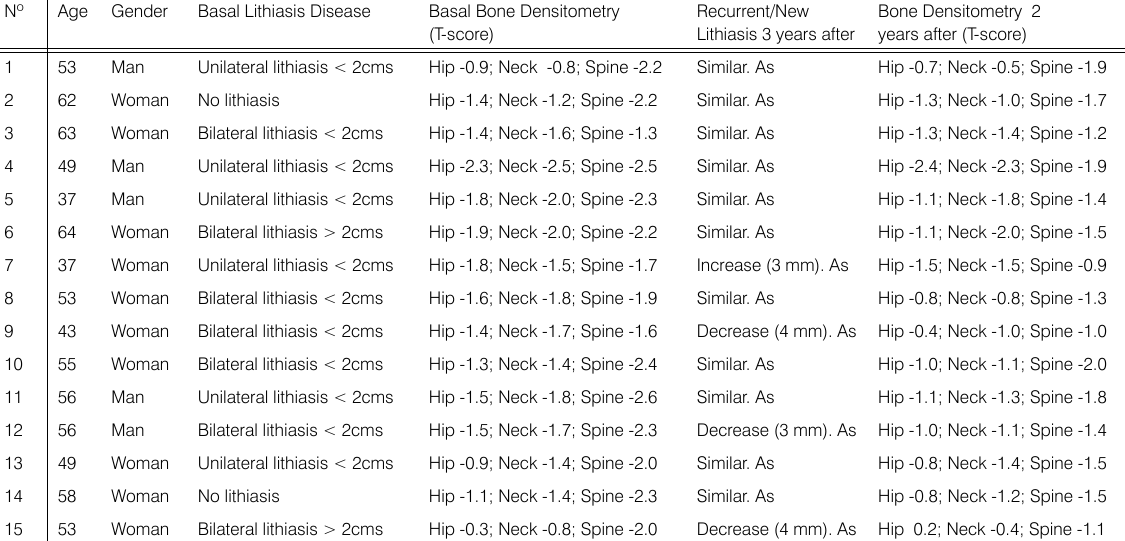
Table 1. Characteristics and evolution of the patients included in the study